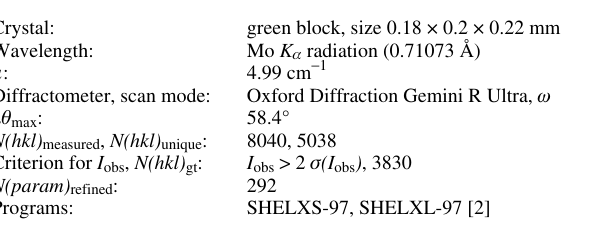
Table 1. Data collection and